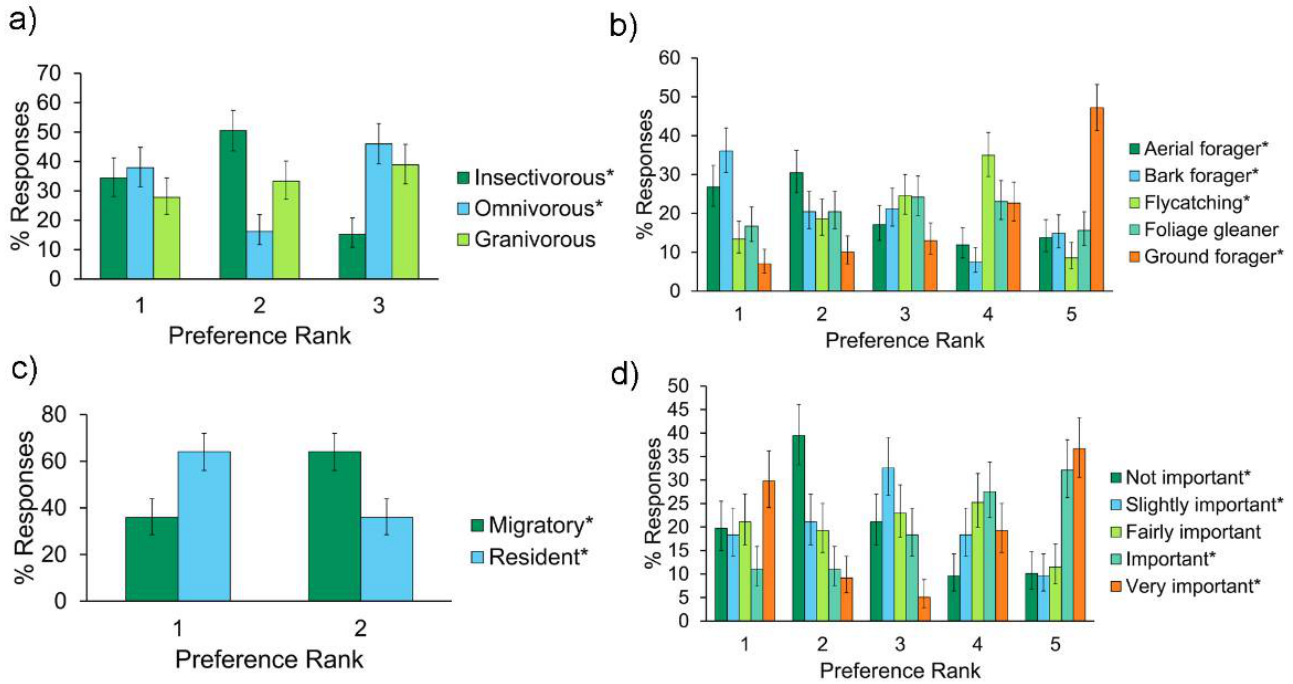
Figure 2. Human preferences (% responses ± 95% CI (Wilson score)) for the dietary habit ( a ), foraging behavior ( b ), migratory behavior ( c ), and cultural importance ( d ) of forest generalist and edge/open country songbird species. Cultural importance was measured as the number of results from a Google search for each species’ common name in quotation marks. Preference rank varied from most (1) to least (2–5) preferred. Asterisks indicate that, for a given trait category, the distribution of the number of responses across ranks differed significantly ( p < 0.001) from the expectation that all ranks had an equal number of responses (note that the significance indicated for resident species is wholly dependent on that for migratory species).